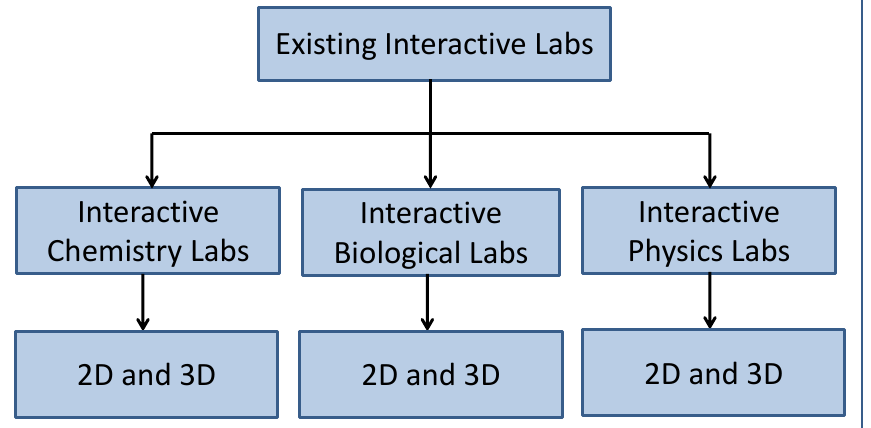
Figure 2. Classification of the existing